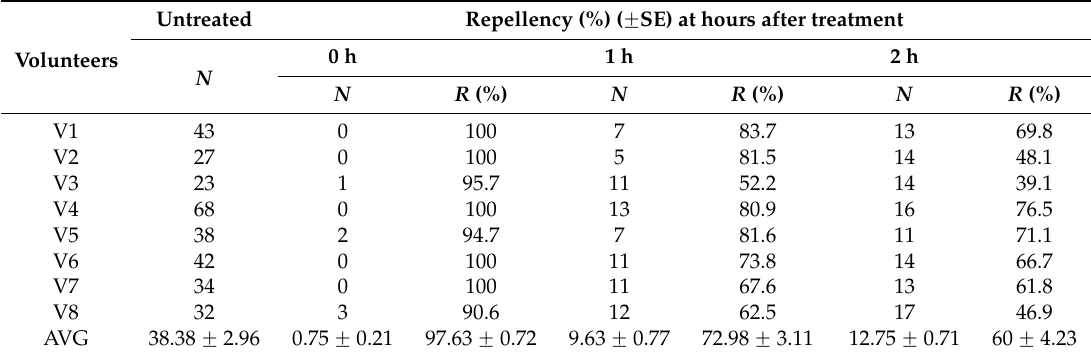
Table 2. Repellency of 5% VS-citral against Aedes albopictus in laboratory